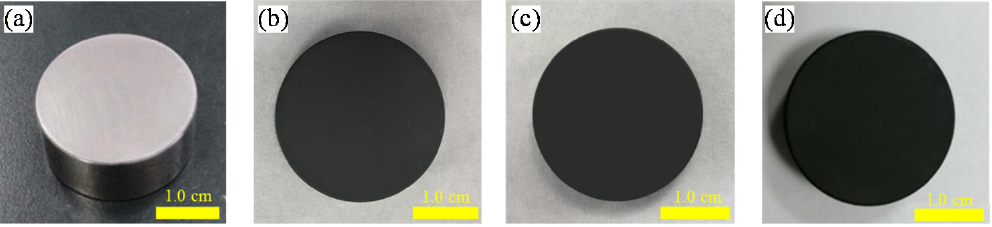
Figure 2. Manganese phosphate conversion coating samples with different thickness. ( a ) Uncoated, ( b ) Mn-P[A], ( c ) Mn-P[B], ( d ) Mn-P[C].